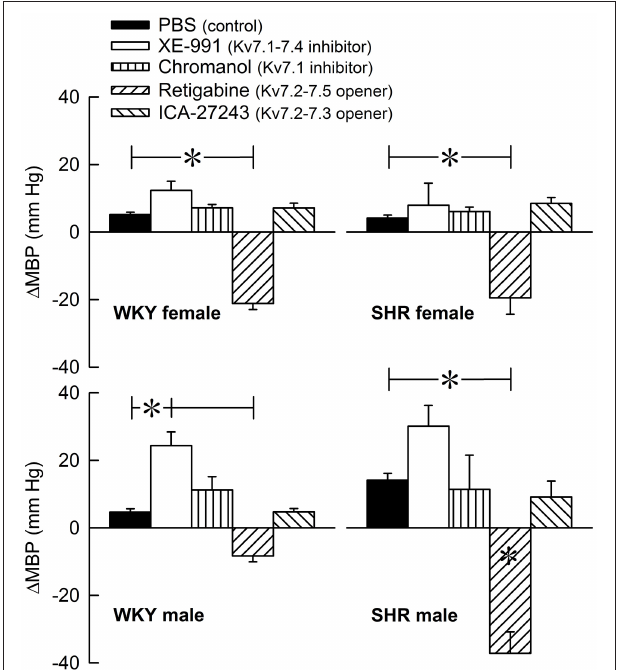
FIGURE 5 | The acute MBP-response to Kv7 inhibitors/openers. The MBP-response was recorded at the time of maximum change in TPR ( Figure 2 ). The rats were injected with PBS (controls) or Kv7 inhibitor or opener, as indicated by the symbol legends. Comparisons were made between corresponding PBS-control and experimental groups, and for corresponding experimental groups across sex (none detected) or strain (*within column). Analyses were done by one-way ANOVA, followed by Student’s t - or Kruskal–Wallis test. * P ≤ 0.0125.